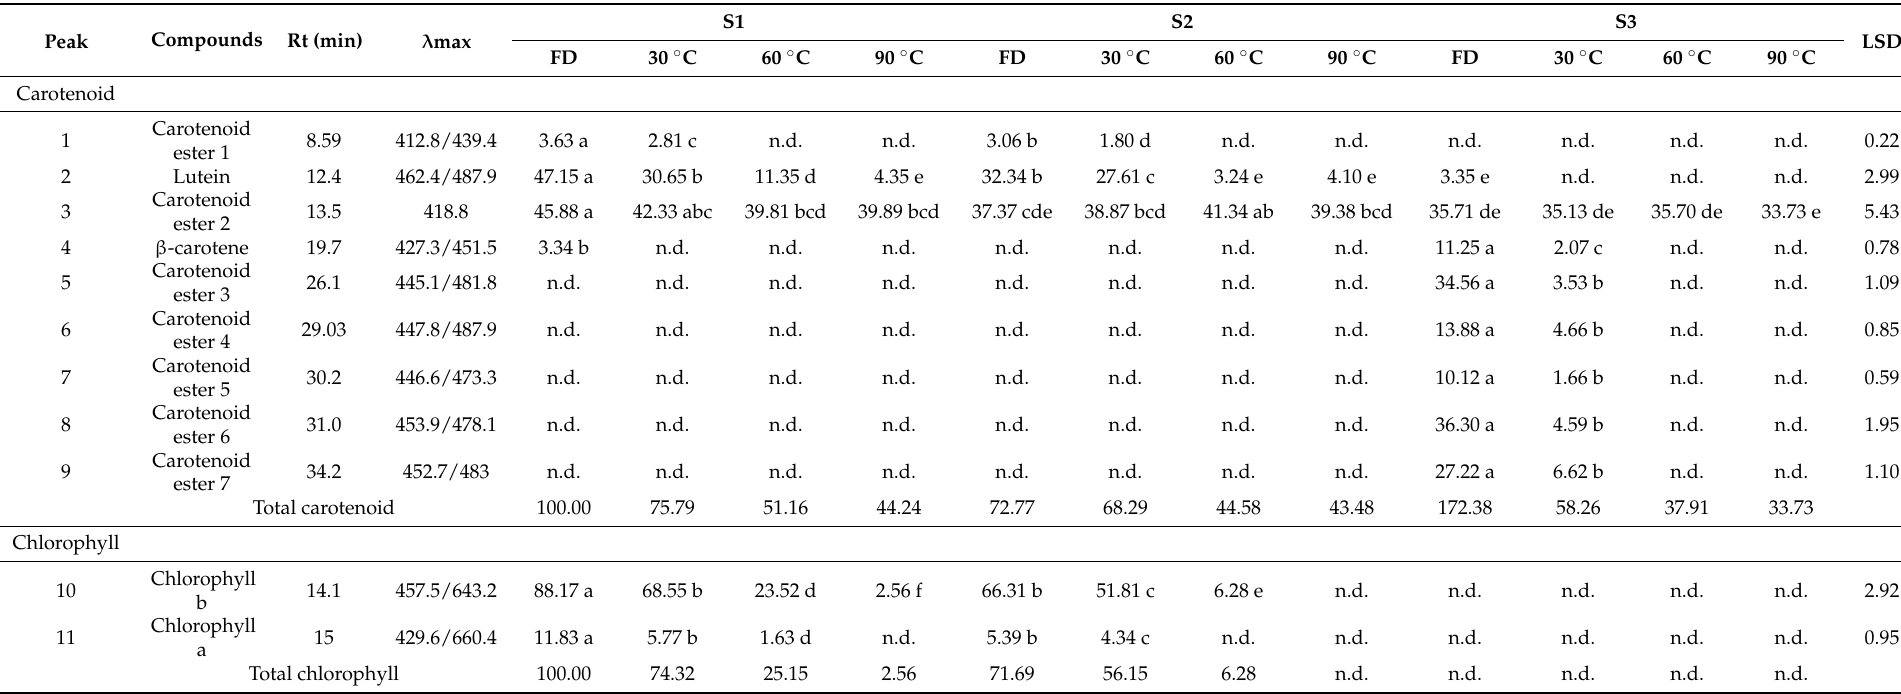
Table 2. Carotenoid and chlorophyll content (%) by drying temperature of M. charantia at different maturity